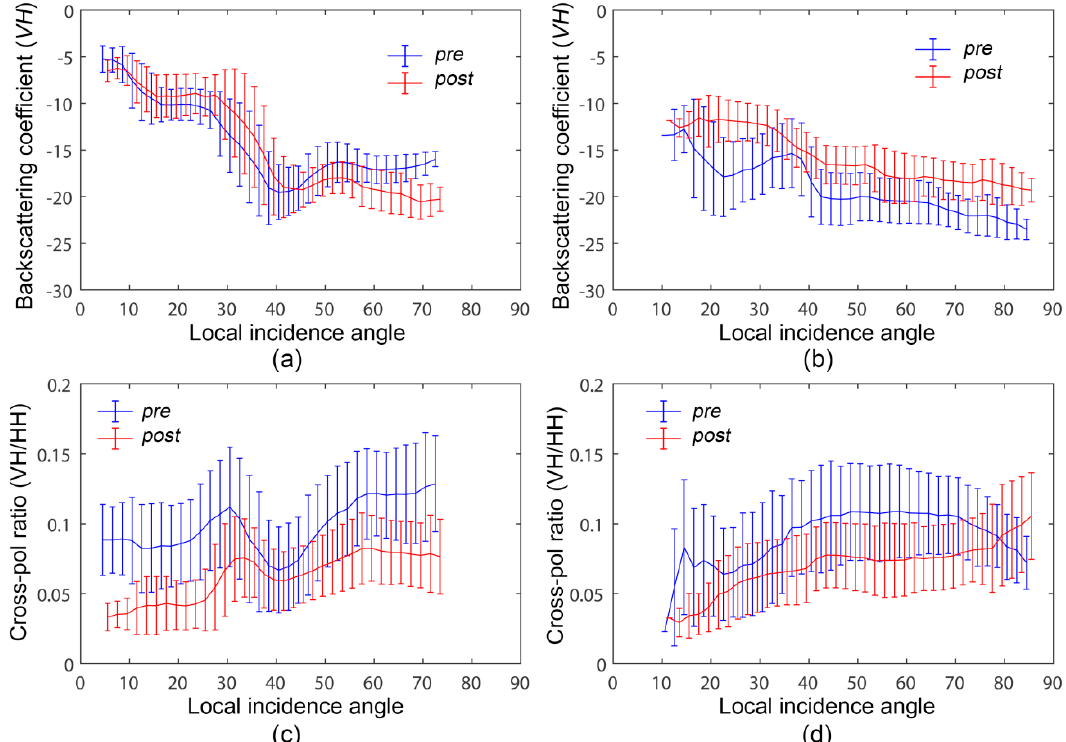
Figure 4. Changes of the VH-polarization backscattering coefficient ( a , b ) and the cross-pol ratio ( c , d ) for forested (left) and non-forested (right) areas with respect to the local incidence angle.